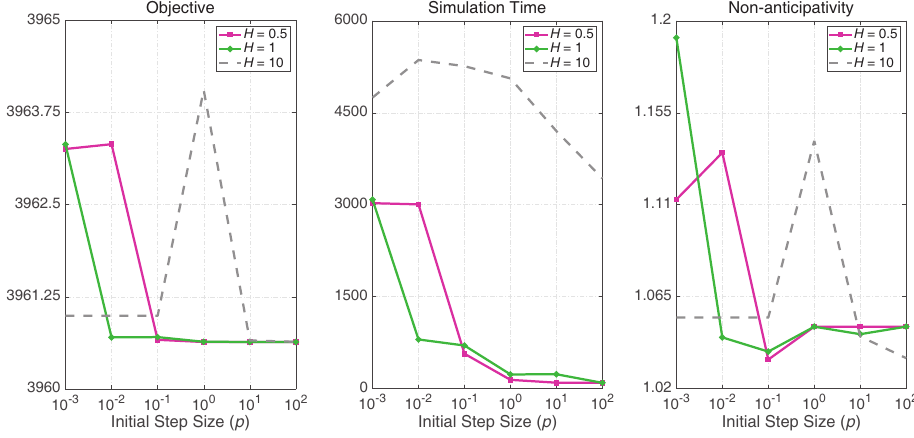
Figure 5. PB method termination results rate for different H